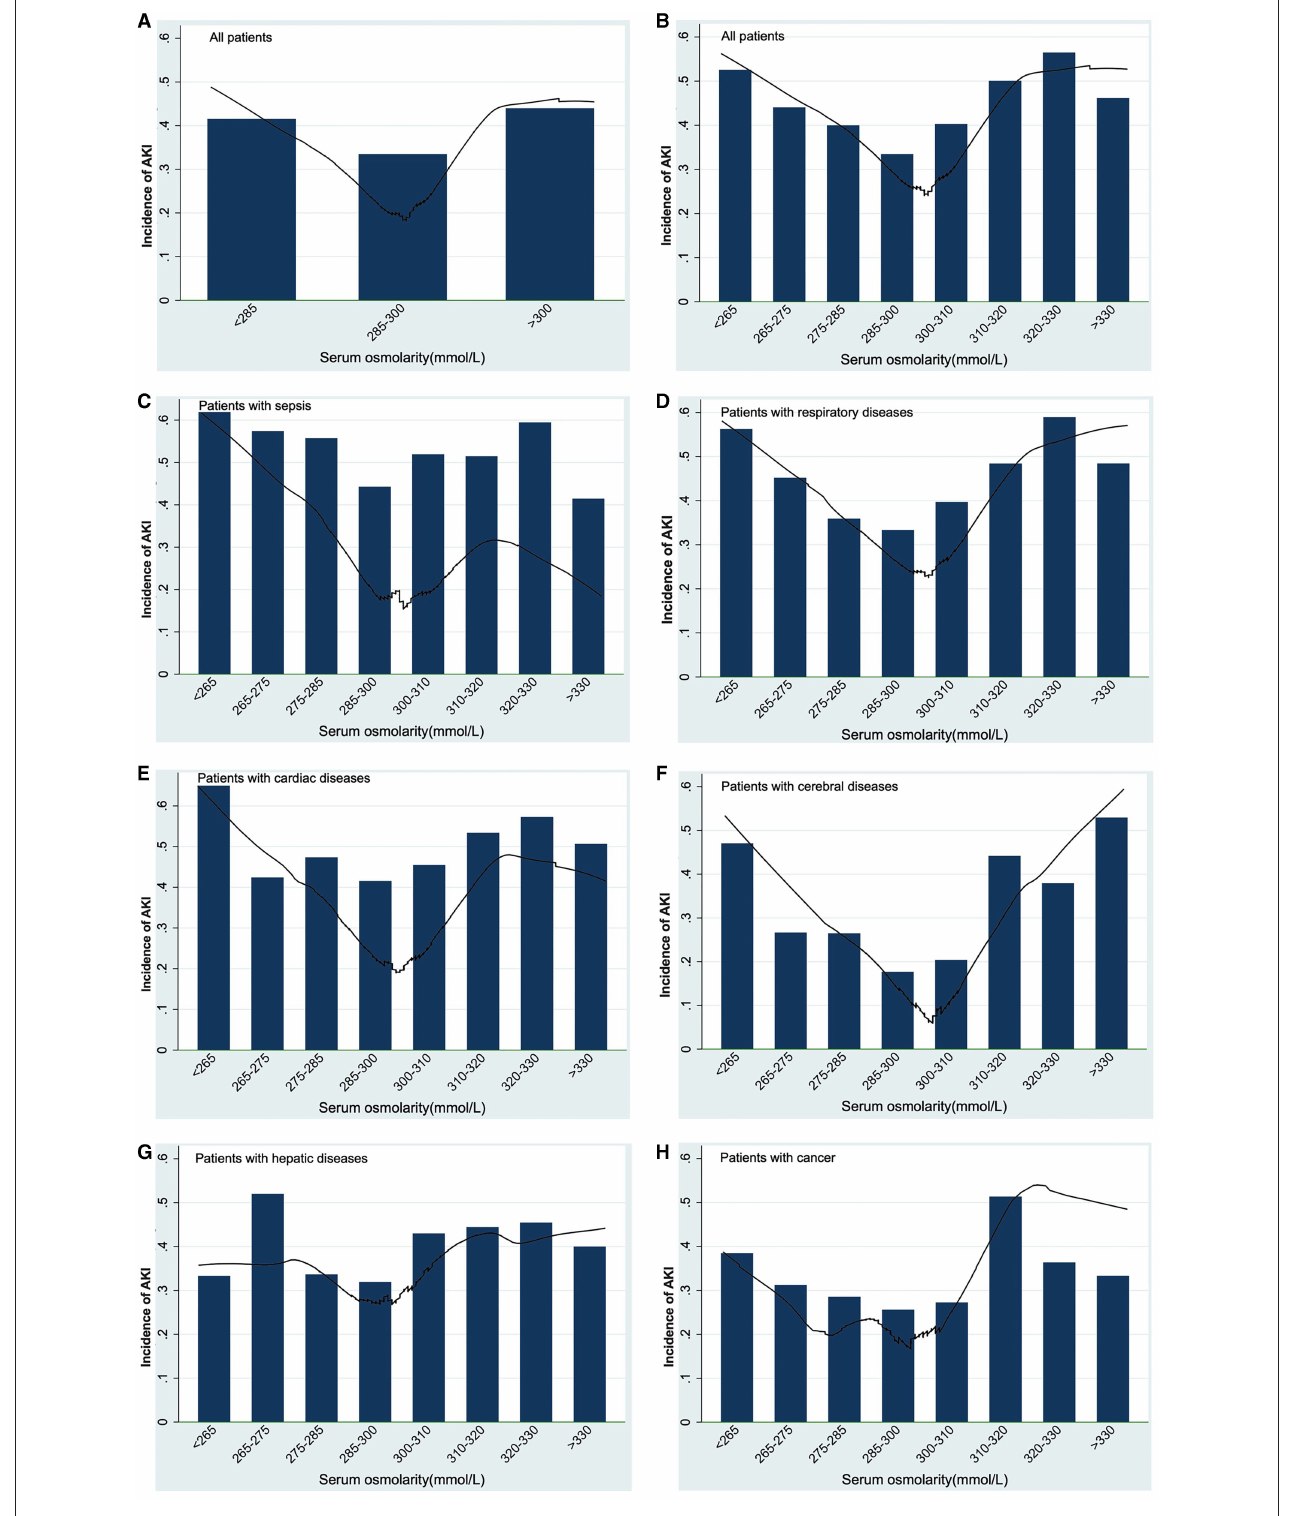
FIGURE 2 | Association between serum osmolality and the development of AKI using Lowess smoothing: (A,B) , all patients; (C) patients with sepsis; (D) patients with respiratory diseases; (E) patients with cardiac diseases; (F) patients with cerebral diseases; (G) patients with hepatic diseases; (H) patients with cancer. Non-liner relationships (U-shaped curves) were exhibited in the present figure.